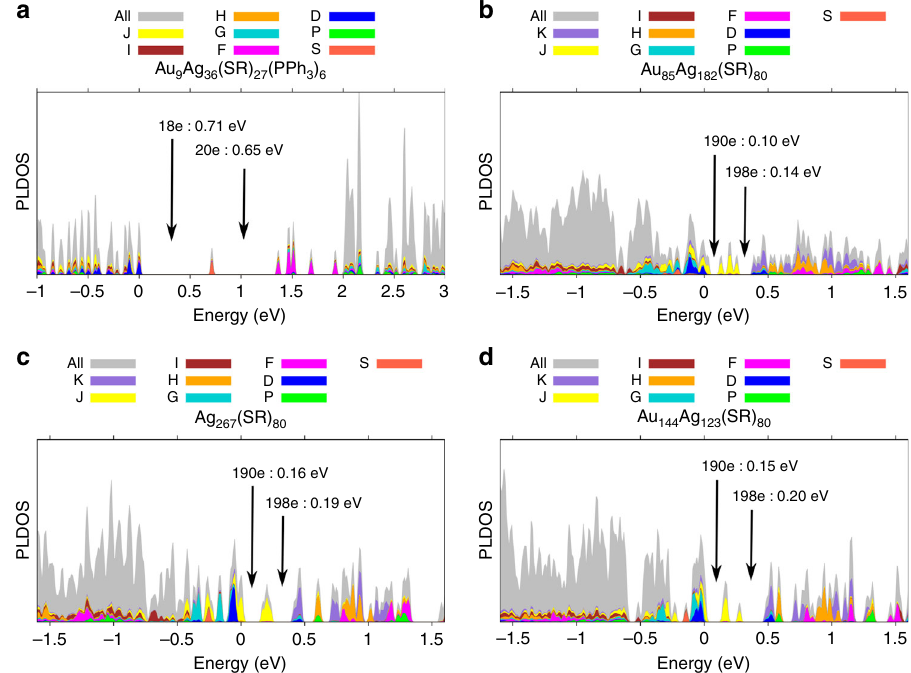
Fig. 5 Calculated electronic structures of (AuAg) 267 and (AuAg) 45 . a Projected Local Density of States (PLDOS) of the (AuAg) 45 cluster. b – d The same analysis for a hypothetical all-silver Ag 267 and for two intermetallic clusters with compositions of Au 85 Ag 182 and Au 144 Ag 123 , all computed in the nanoparticle observed crystal structure of (AuAg) 267 . The various colors denote the weights of orbitals projected onto spherical harmonics, centered at the cluster center-of-mass. The energy of the highest occupied molecular orbital (HOMO) is at zero. The major energy gaps around or above the HOMO energy are indicated by arrows the cumulative gap at 20 shell electrons are both visible in the calculation of E(Q) , see Supplementary Figs. 14 and 15. Hence, the calculations predict that (AuAg) 45 should contribute just a few discrete charging peaks in the energy (voltage) region probed by the DPV experiment. The exact locations of those charging peaks are undetermined since the relative redox potentials of the larger and smaller particles are not known. However, we note that the experimental DPV data of (AuAg) 267 ∙ (AuAg) 45 indeed is more complex than the data from Ag 206 that we reported recently 38 , which may result from the presence of two particles having distinctly different redox behaviors.